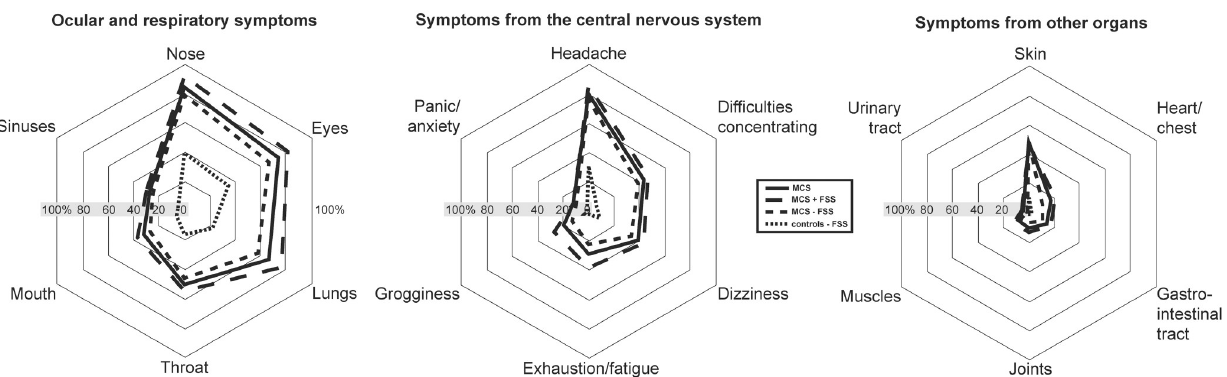
Fig 2. Prevalence of symptoms associated with inhalation of airborne chemicals. Abbreviations: MCS = Multiple chemical sensitivity; FSS = functional somatic syndromes; MCS all = all participants meeting criteria for multiple chemical sensitivity; MCS + FSS = participants meeting criteria for multiple chemical sensitivity and one or more comorbid FSS. MCS � FSS = participants meeting criteria for multiple chemical sensitivity but not comorbid FSS.